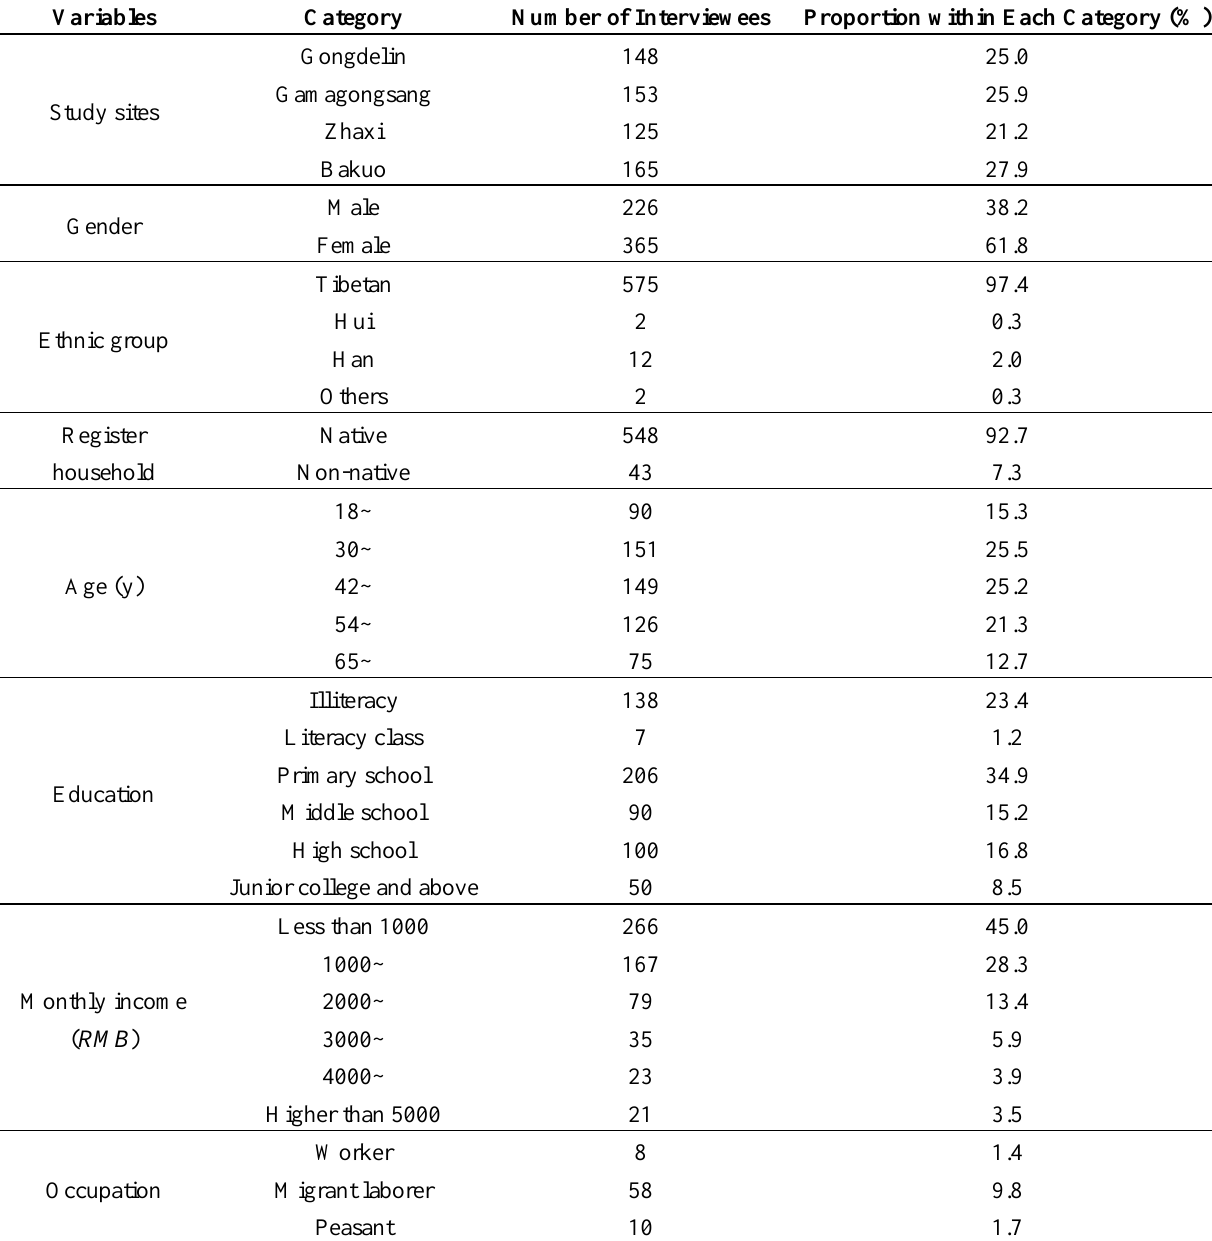
Table 1. Socio-Demographic characteristics of the study participants ( N = 591) in urban Lhasa City,